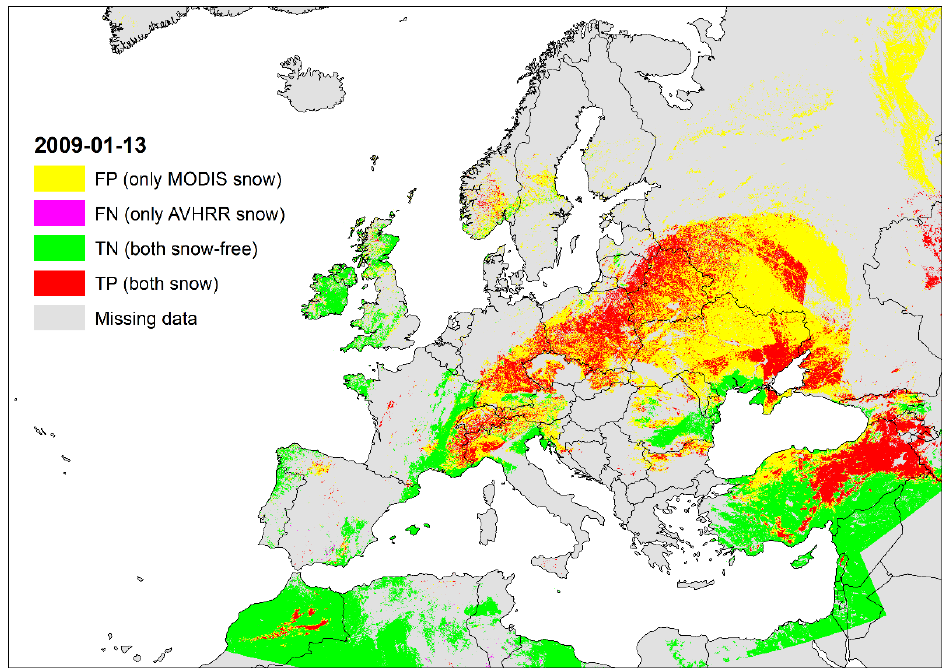
Figure 10. Daily composite of the classification accuracy for 13 January 2009–the date with the fewest matches between MODIS and AVHRR (TNR: 47.5%, PPV: 34.25%, and ACC: 58.67%).